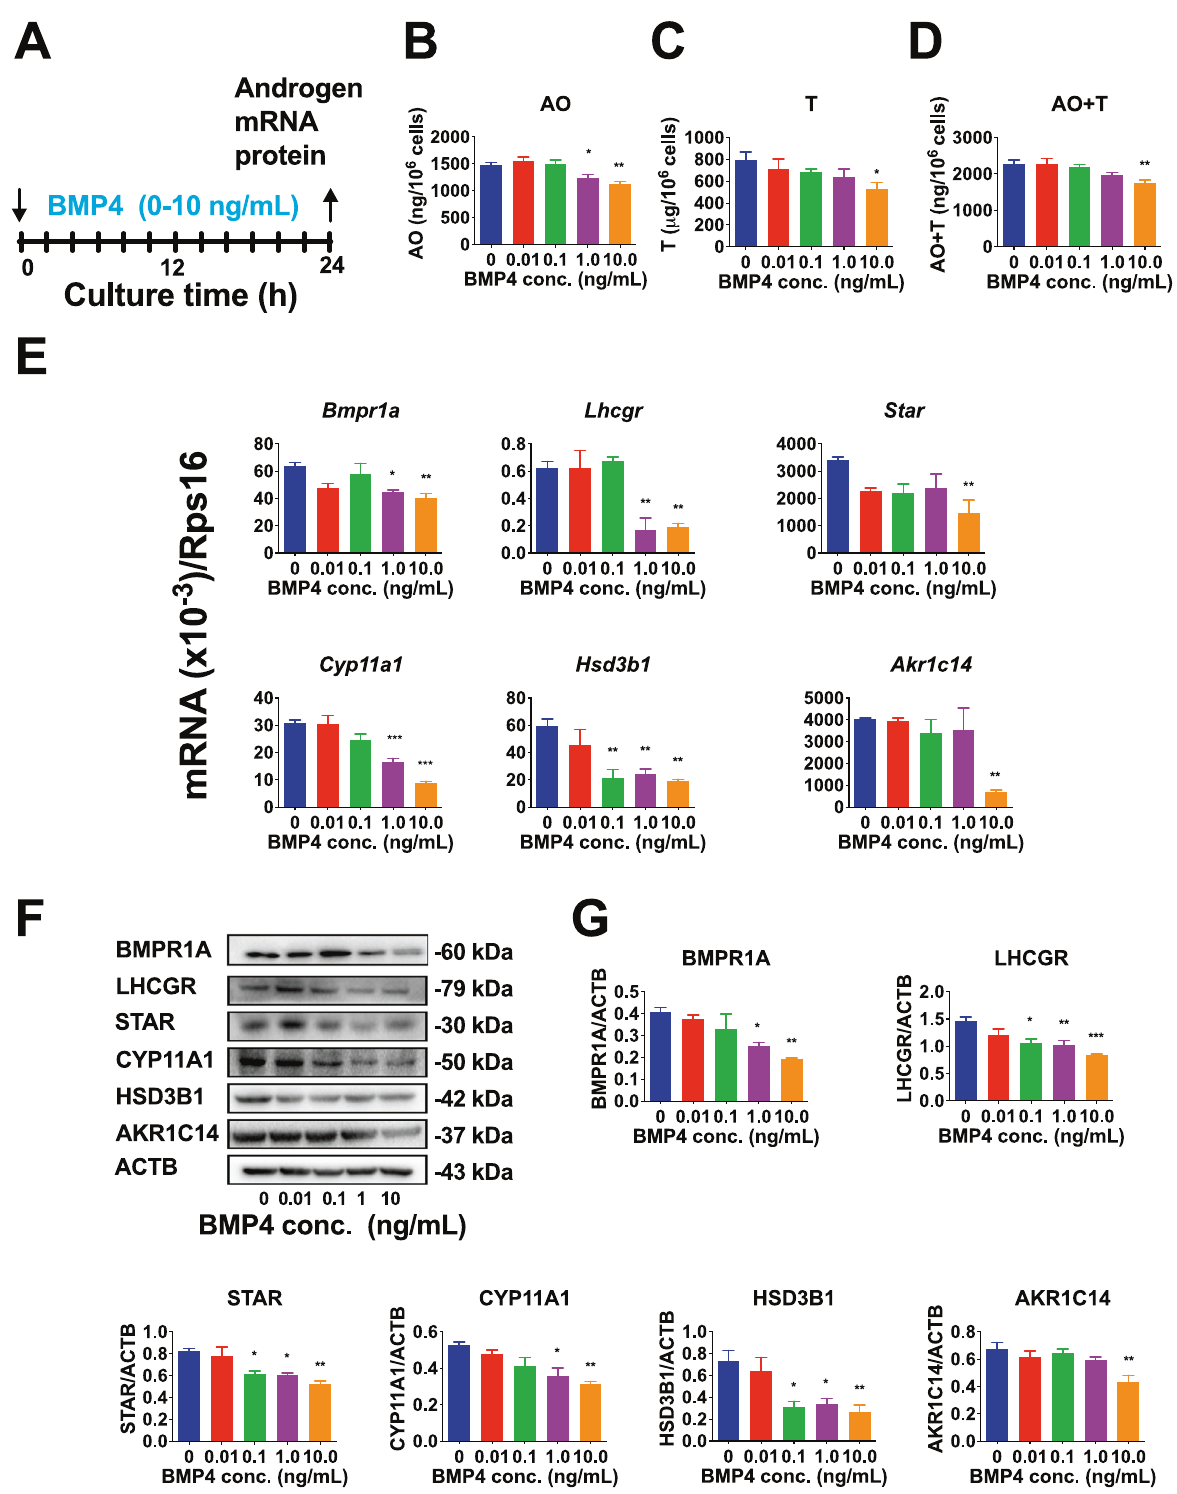
Fig. 2 BMP4 inhibits progenitor Leydig cell (PLC) differentiation in vitro. A PLCs were incubated with BMP4 for 24 h. B – D Androsterone (AO), T, AO + T output after BMP4 treatment; Mean ± SEM, n = 4. E QPCR detection of Bmpr1a , Lhcgr , Star , Cyp11a1 , Hsd3b1 , and Akr1c14 expression which was normalized to Rps16 (an internal control); Mean ± SEM, n = 4. F Western blot. G Quantitative results of BMPR1A, LHCGR, STAR, CYP11A1, HSD3B1, and AKR1C14 protein levels which were normalized to ACTB (an internal control); Mean ± SEM, n = 3. * P < 0.05, ** P < 0.01 and *** P < 0.001 indicate signi fi cant differences compared to control (0 ng/mL BMP4).